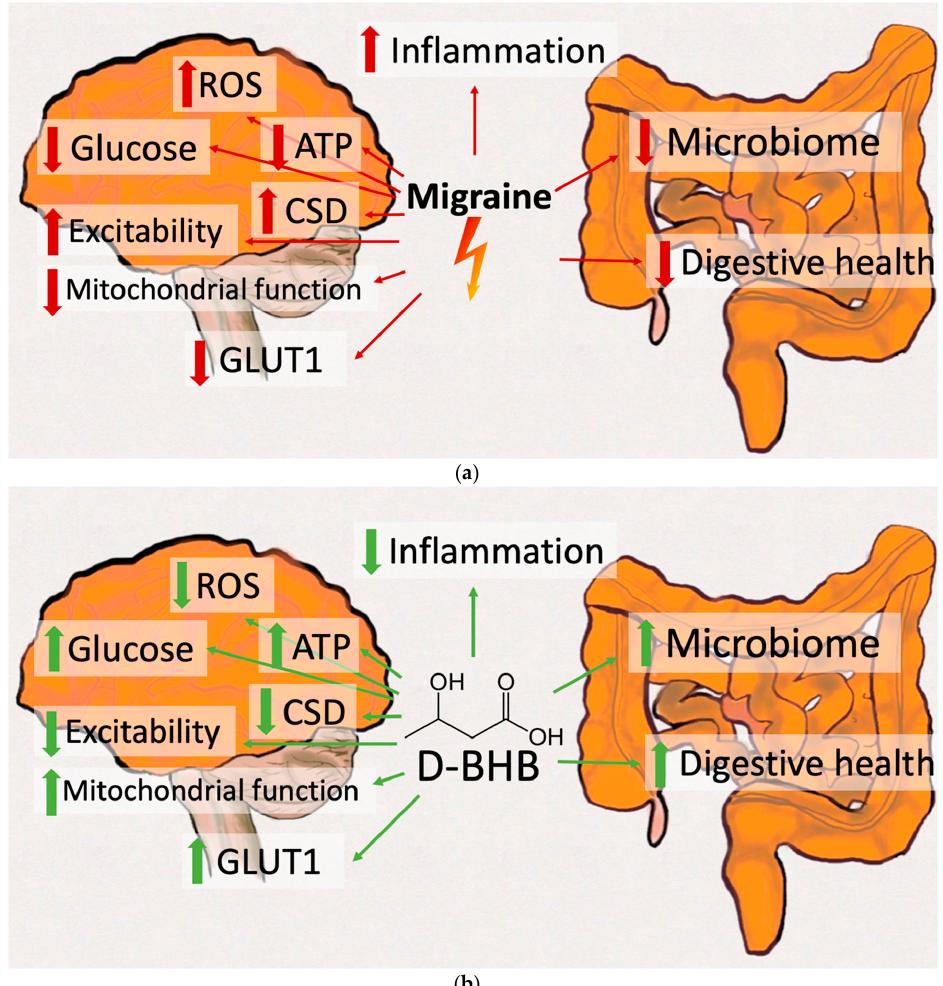
Figure 1. Potentially migraine relevant mechanisms of ketosis. ( a ) Amongst key migraine pathophysiological mechanisms are hypometabolism, decreased glucose transport (including glucose transporter 1 (GLUT1) deficiency), reduced mitochondrial functioning, increased cerebral excitability, increased cortical spreading depressions (CSD) incidence, increased oxidative stress (reactive oxygen species (ROS)), increased inflammation, microbiome abnormalities and reduced digestive health. ( b ) D- β -hydroxybutyrate (D-BHB; with or without the context of a ketogenic diet) has been shown to positively influence each of these mechanisms: increasing cerebral metabolism, increasing glucose transport (including glucose transporter 1 (GLUT1) deficiency), increasing mitochondrial functioning, reducing cerebral excitability, decreasing cortical spreading depressions (CSD) incidence, reducing oxidative stress (reactive oxygen species (ROS)), decreasing inflammation, improving the microbiome and increasing digestive health. ATP = adenosine triphosphate; CSD = cortical spreading depressions; D-BHB = D- β -hydroxybutyrate; GLUT1 = glucose transporter 1; ROS = reactive oxygen